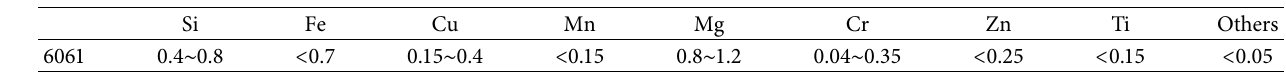
Table 3: Main components of aluminum alloy